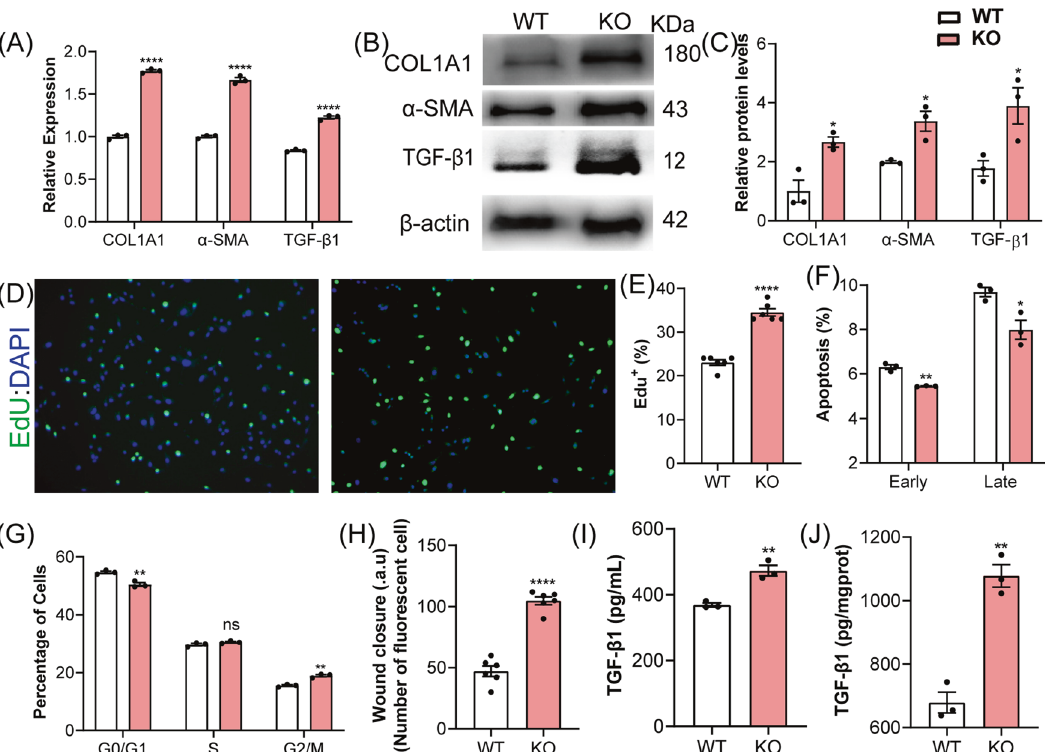
Fig. 3 Mybpc3 de fi ciency enhanced myo fi broblasts conversion. A – C The transcript ( A ) and protein ( B , C ) expression of COL1A1, α -SMA, and TGF- β 1 in WT and MYBPC3-KO fi broblasts. **** P < 0.0001. D – F The de fi ciency of Mybpc3 gene increased fi broblast proliferation and reduced apoptosis. * P < 0.05; ** P < 0.01; *** P < 0.001. G Cell cycle analysis showed that Mybpc3 disruption increased cells in the G2/M phase while slightly reducing cells in the G0/G1 phase. ns, not signi fi cant; ** P < 0.01. H Measurement of fi broblast migration by the cell wound scratch assay. **** P < 0.0001. I , J Measurement of TGF- β 1 in the culture supernatant and cell lysate of WT and MYBPC3-KO fi broblasts. ** P <